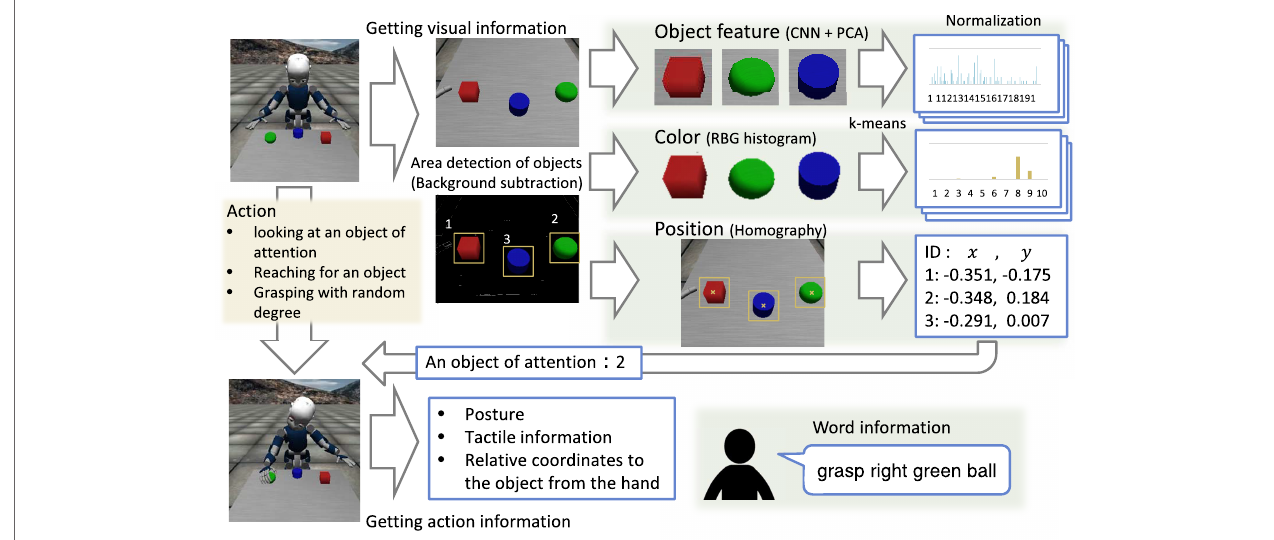
FIGURE 3 | Procedure for obtaining and processing